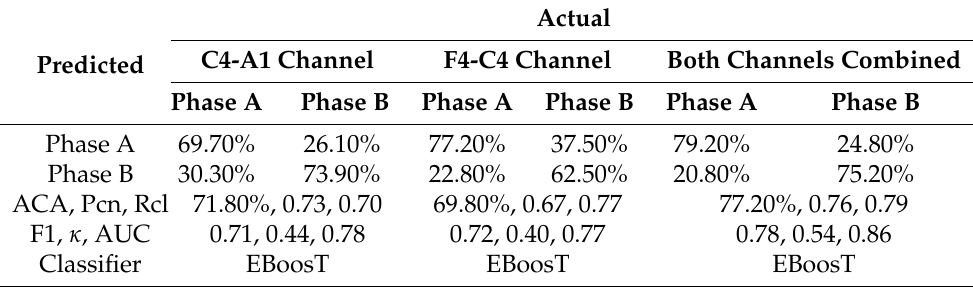
Table 6. Classification performance for narcolepsy